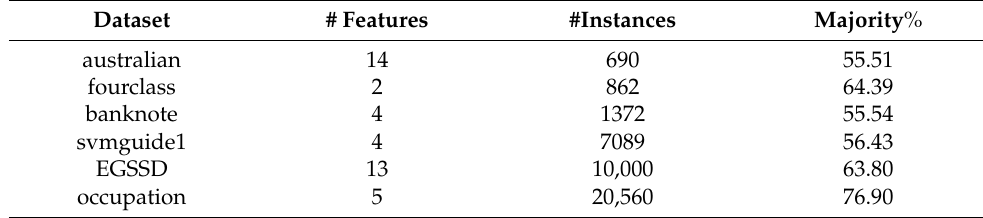
Table 2. Specifications of the public